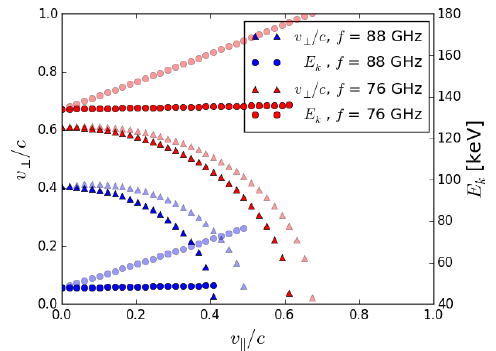
Figure 3. Solution of the resonance condition for the velocities ( (cid:52) ) and the electron kinetic energy E k ( • ) relevant to the plotted point of the phase space for the 3 rd harmonic for the boundary E2-band frequencies. Rich colour : N || = 0 . 005; Pale colour : N || = 0 .